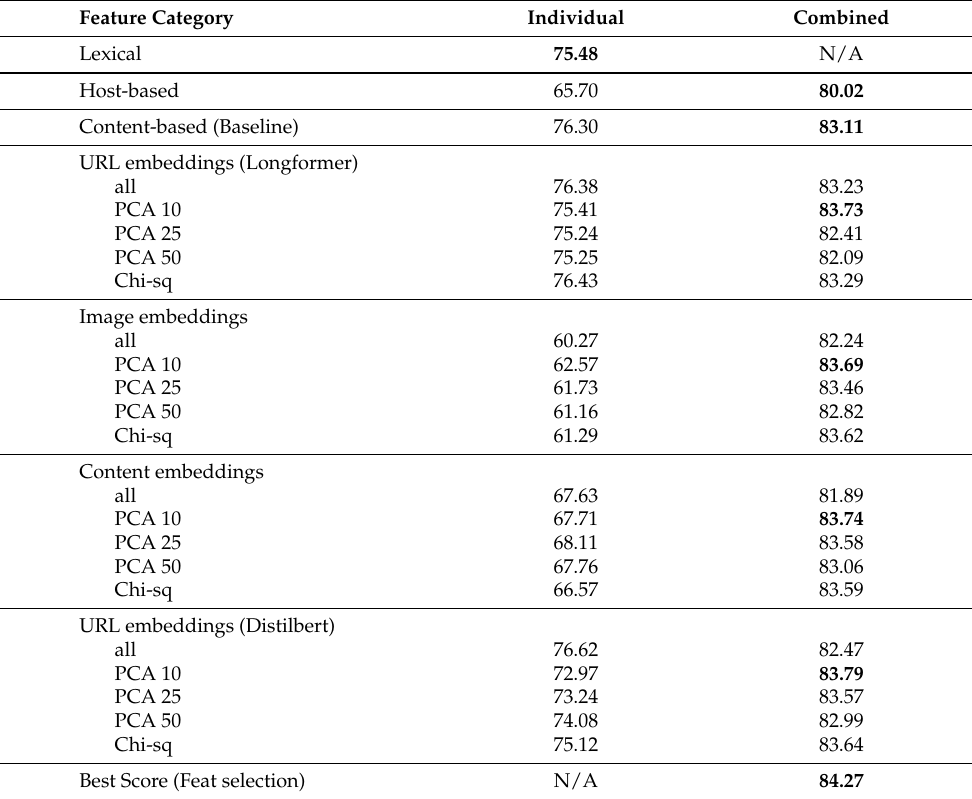
Table 4. Test accuracy for XGBoost across different feature combinations. The individual column shows the accuracy when these features are used for training on their own. The combined column shows accuracy when combined with the preceding feature category in the table. Highlighted scores are the best score for that particular combination of